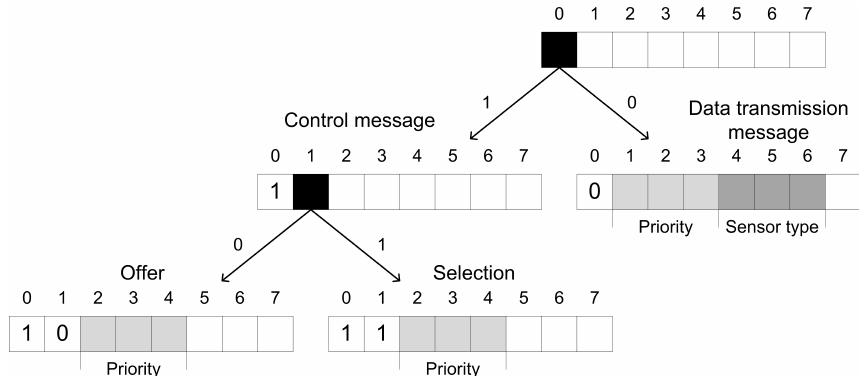
Figure 2. Bitwise distribution of message types.